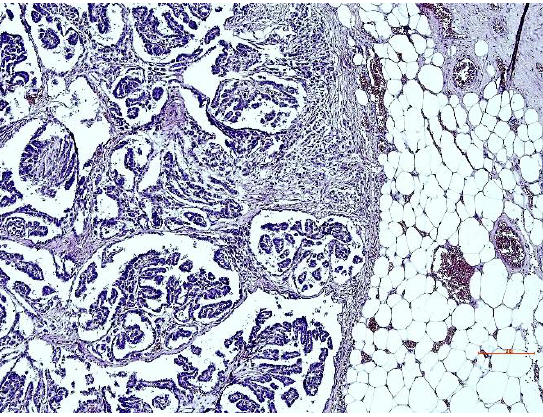
Figure 6. Lung : tubulo-papillary structure, with multiple layers of neoplastic cells. H & E stain. Bar = 100 µm.